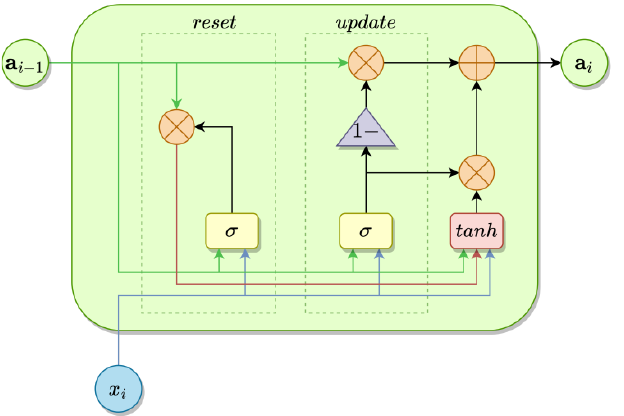
Figure 6. GRU unit structure.